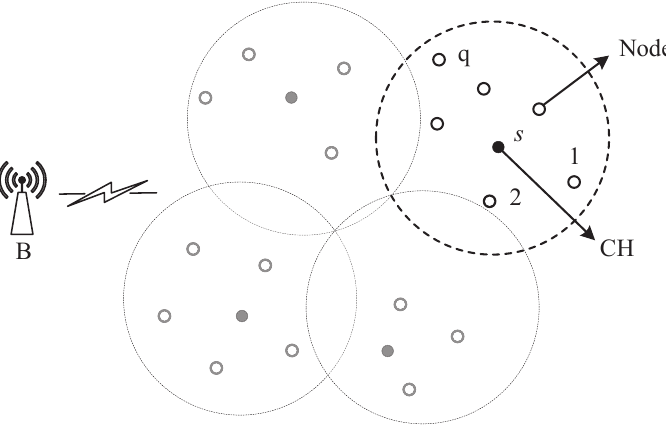
Figure 1. Topology of wireless sensor